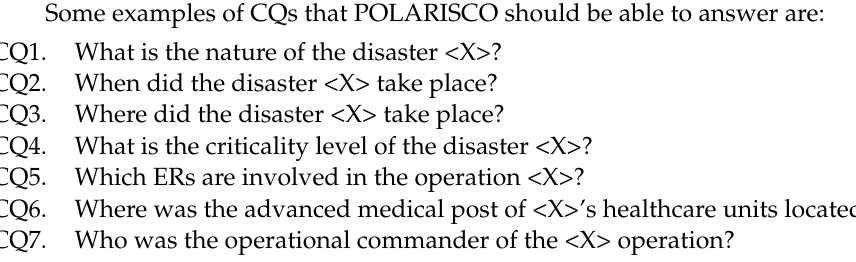
Figure 3. POLARISCO knowledge